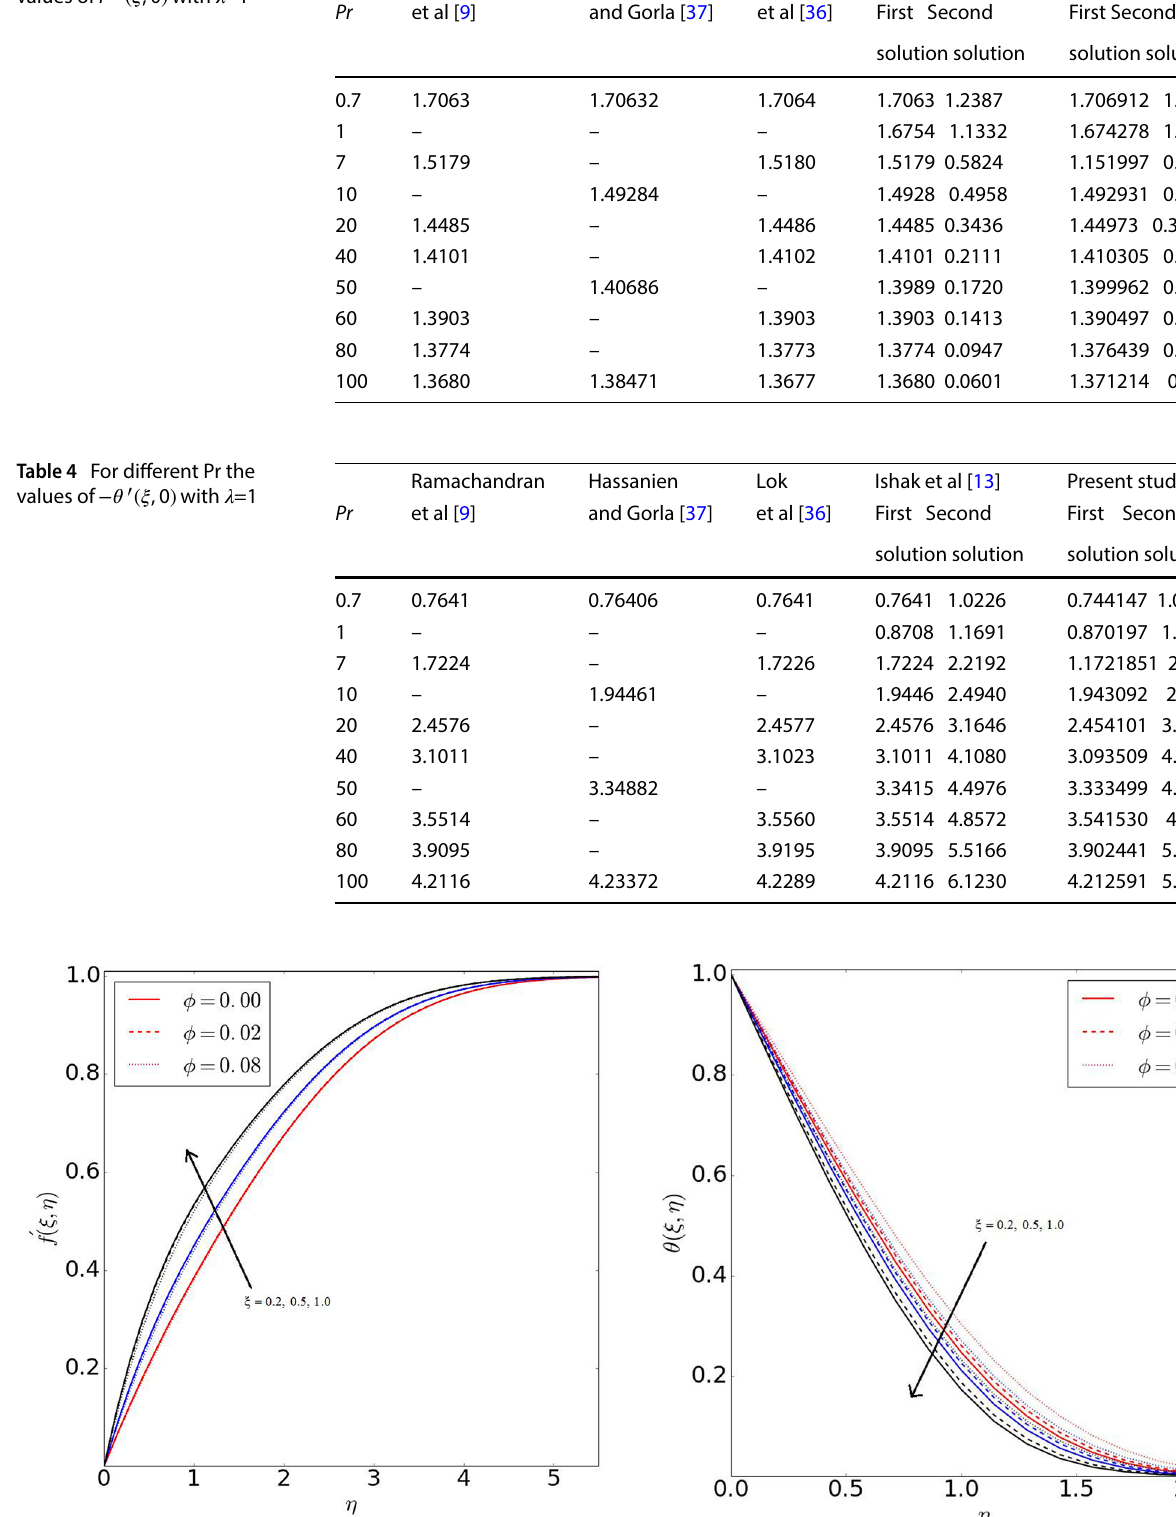
Table 3 For different Pr the values of f �� ( 𝜉 ,0 ) with 𝜆 =1